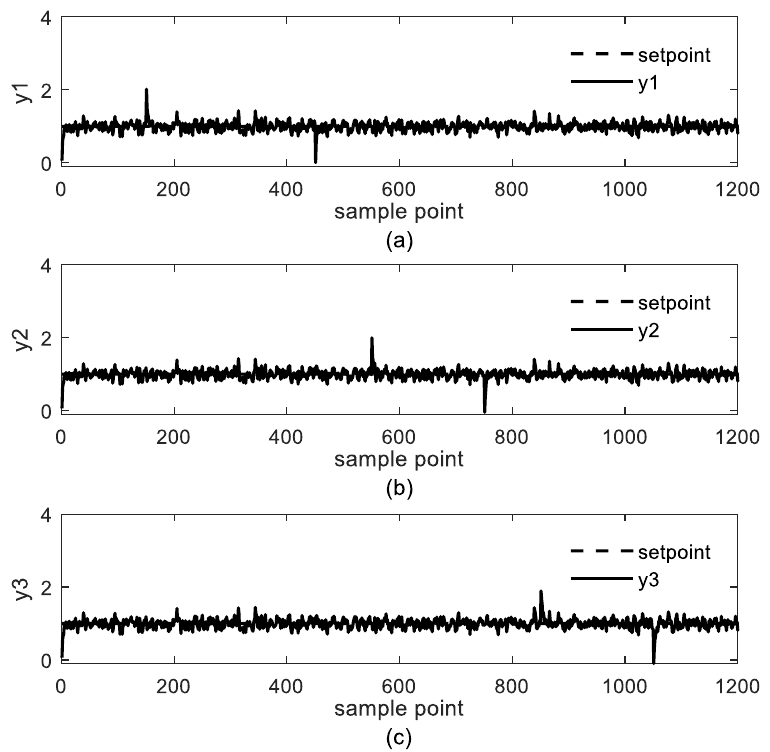
Figure 17. The simulation result of OSDP1 with white noise: ( a ) y 1 —production; ( b ) y 2 —slurry polymer; ( c ) y 3 —catalyst efficiency.